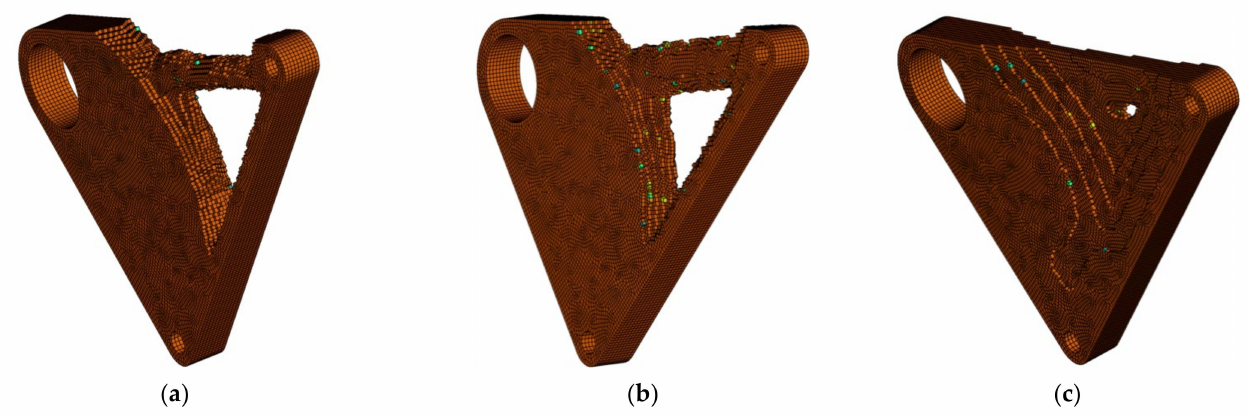
Figure 14. TO results for various manufacturing angles ω at the manufacturing rate g = 0.7, all elements whose design variable is greater than 0.1 are displayed. Additionally, the number of iterations until convergence is noted. ( a ) ω = 15 deg, iterations: 76; ( b ) ω = 45 deg, iterations: 41 ( c ) ω = 75 deg, iterations: